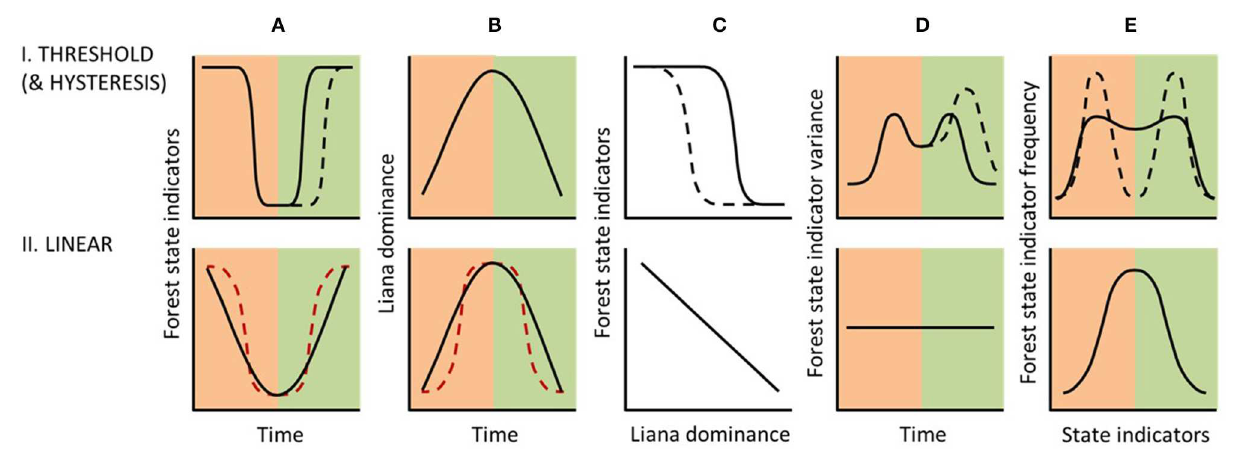
FIGURE 7 | Theoretical application of five established figures for diagnosing thresholds (Bestelmeyer et al., 2011) to distinguish between alternative forest response classes under liana proliferation following heavy disturbance. Peach and green shading, respectively, show phases of disturbance and recovery (A,B,D) , or primary and secondary forest (E) . While an abrupt change in the “biological response”, i.e., forest state indicators, over time (A-I) might be indicative of a Threshold Response Class, this would have to be driven by a non-abrupt increase (or experimentally manipulated variation) in liana dominance (B-I) to indicate a true threshold. Consequently, the response curve (C-I , from Figure 4) should then show an abrupt non-linear relationship. This assumes that other drivers remain constant over the same time period. Further verification of a threshold could be identified from increased variance in forest state indicators during and immediately prior to the threshold in (A-I, D-I) and from a bimodal frequency of forest state indicators across the study landscape (E-I) . In the absence of a threshold, liana dominance and forest state indicators would be expected to covary under a Linear Response Class (C-II , from Figure 4) , and hence show similar trends over time (A-II and B-II) , or would show no relationship at all if lianas are not driving forest state change (not illustrated). Similarly, in the absence of a threshold, forest state indicators would be expected to show no temporal change in variance (D-II) and a unimodal frequency distribution (E-II) . Black dashed lines further indicate expected trajectories under a Hysteretic Response Class. Red dashed lines indicate a false (driver) threshold whereby an abrupt change in forest state indicators (A-II) has resulted from an abrupt change in liana dominance (B-II) . For simplicity, expected variation in state indicators is not shown, plus disturbance and recovery phases are shown as equal in duration, but this is highly